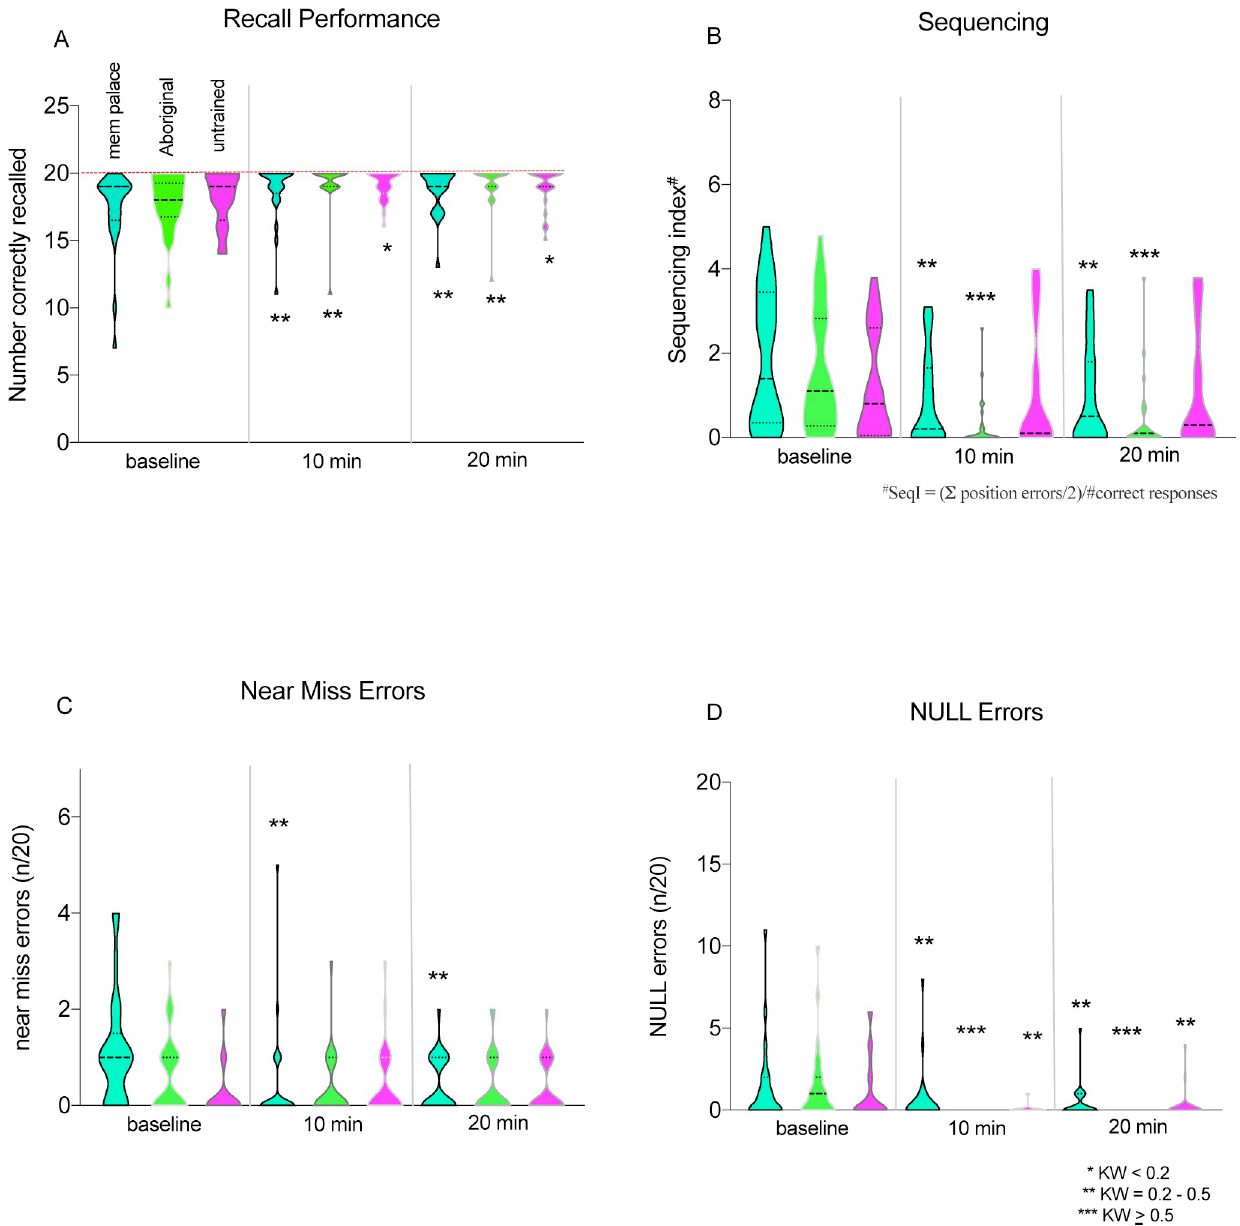
Fig 2. Recall and error performance before and after training. Violin plots indicate: A) Recall scores for each study group at baseline, after a 10 minute recall test, and a subsequent 20 minute delayed recall test. A single 20 minute training session with the memory palace technique or the Australian Aboriginal method elicited equivalent improvement in recall performance, with a smaller improvement observed in the untrained recall group. All groups exhibited a marked ceiling effect, with median baseline values � 17/20 list items. See Results for details and statistical analyses. B) Change in correct sequencing of recalled items post training. Figure colours and conventions as in Fig 2A. The legend at lower right provides the algorithm for determination of a sequencing index which accounts for the trivial observation that a single sequencing error (i.e. placing item 4 in position 6 on the recall list) results in 2 observed errors (at both position 4 and 6). C) Observed incidence of “near miss” errors (entry of a semantically meaningful but closely related term instead of the correct list item, e.g. “metal mask” vs. “metal mark”). D) Observed incidence of NULL errors, in which items were left blank on the recall test